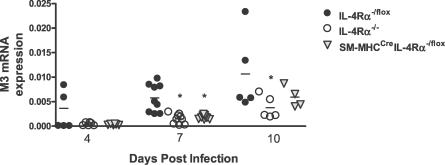
Intestinal Expression of M3 Receptor Is Inhibited by Disrupted Smooth Muscle Cell IL-4Rα ExpressionmRNA was extracted from intestines of N. brasiliensis infected mice at days 4, 7, and 10 PI. Synthesized cDNA was probed with primers to M3. Increases are normalized against α-actin. Data are representative of two to five experiments per time point. n ≥ 4 mice per group. *p < 0.05.